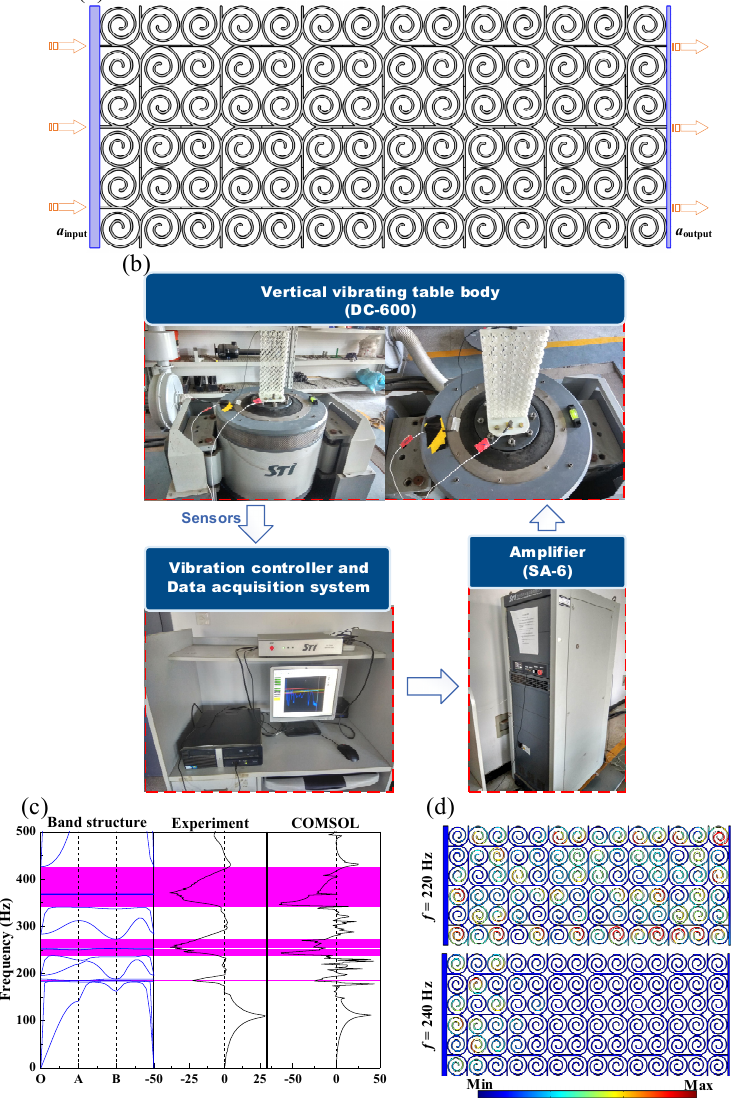
Figure 17. ( a ) Geometry and loading conditions of the SHAMLRAS periodic structure; ( b ) experi- mental setup for transmission loss in SHAMLRAS periodic structures; ( c ) comparative spectrum diagram obtained from transmission loss experiment and simulation; ( d ) deformation of SHAM- LRAS periodic structures under harmonic loading frequency at f = 220 Hz (outside the bandgap region) and f = 240 Hz (inside the bandgap region).